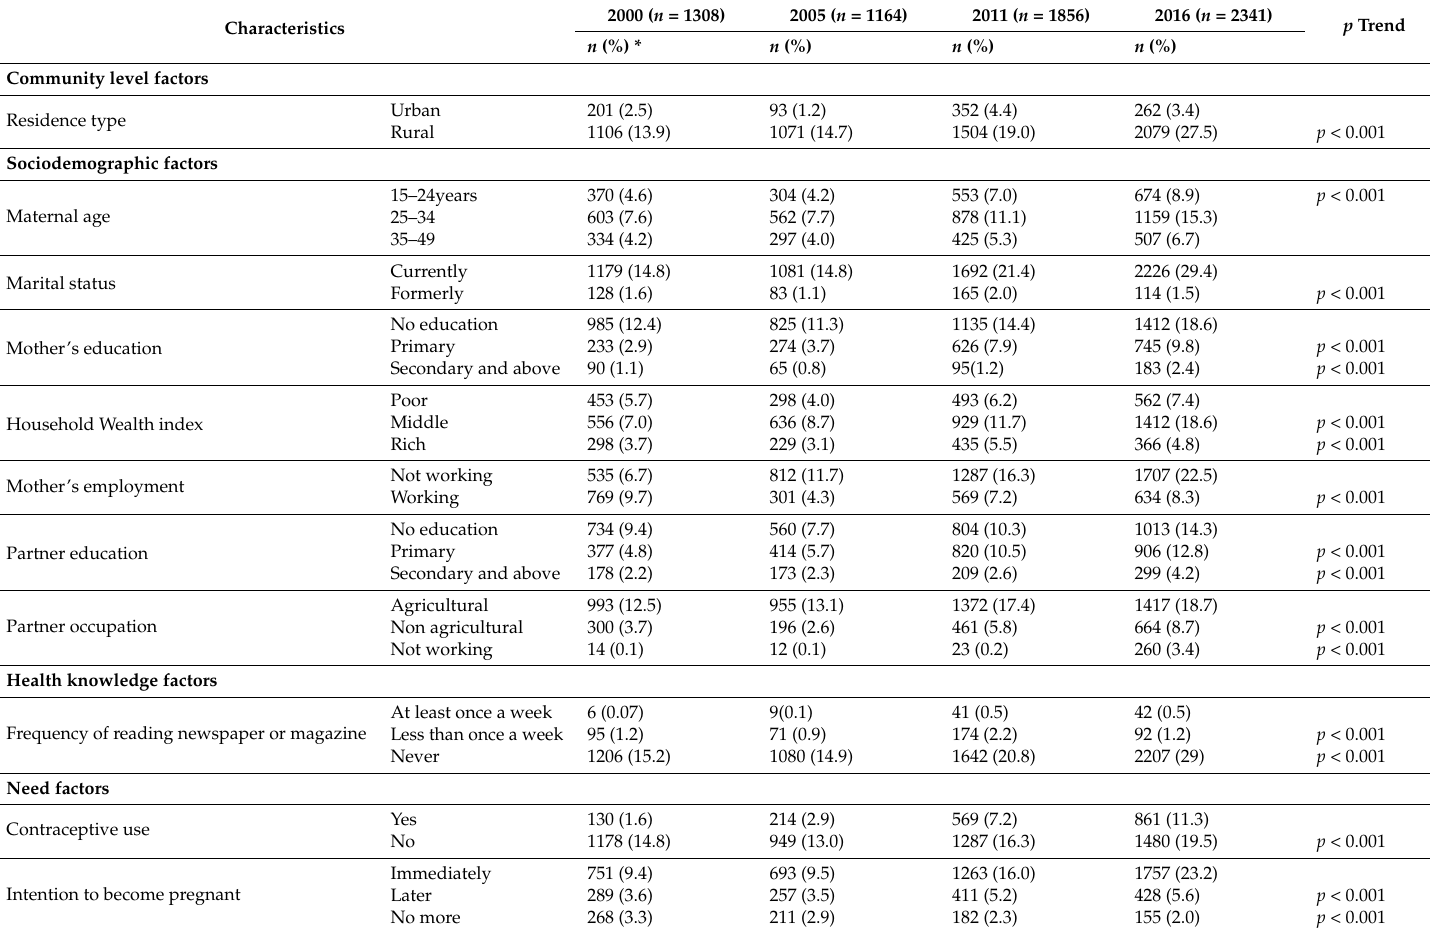
Table 1. Characteristics of the study participants who had one to three Antenatal care (ANC) visits in Ethiopia, 2000–2016.